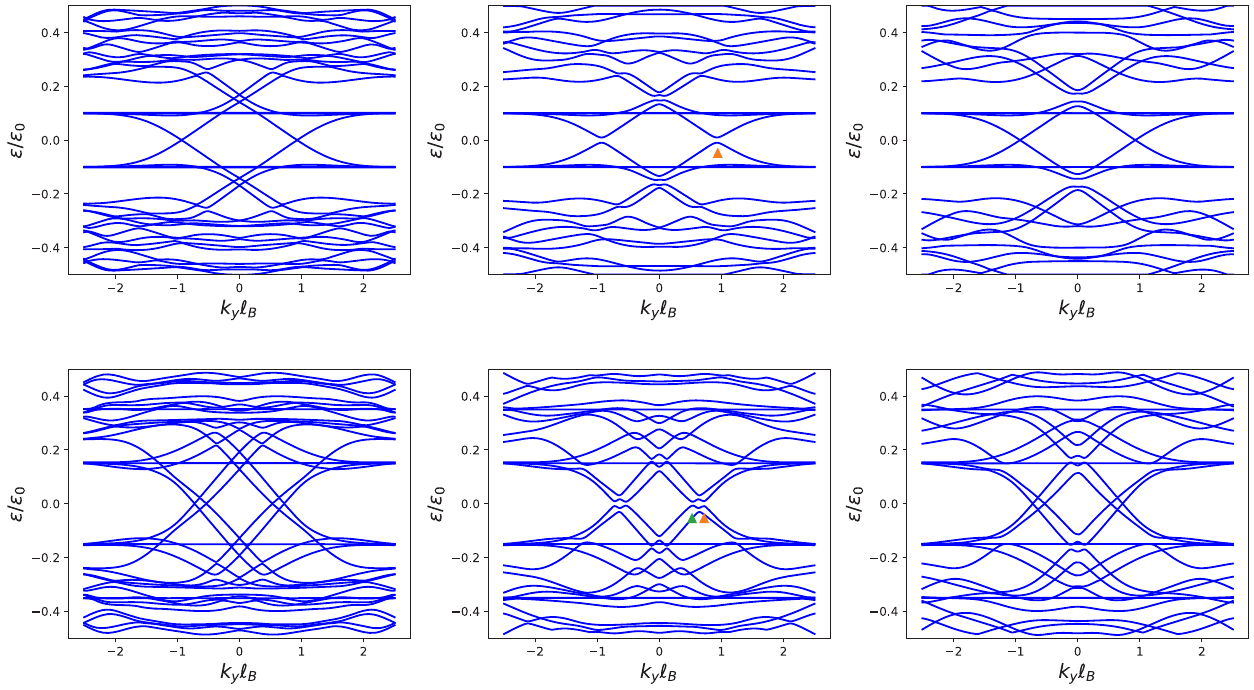
¼ 0 . 3 ε ν ¼ 2 with μ ¼ 0 . 55 ε FIG. 17. Bogoliubov spectrum. Top row: ν ¼ 1 with μ 0 . Bottom row: 0 (see the right-hand panel of n n Fig. S4 in Supplemental Material for the location of the chemical potential [35]). Left-hand column represents the case of a thick ¼ 15 l ¼ 10 ξ ¼ 6 l ¼ 4 ξ superconductor W 0 . Middle and right-hand column correspond to a thin superconductor W s 0 . There is no s B B energy gap in the thick regime, while there is a gap opening in the thin regime when spin-orbit coupling is present (middle column). For ¼ ε reference, we provide the right-hand column which has no spin-orbit coupling. In the other panels we set λ 0 . It is evident that Rx either turning off the spin-orbit coupling or making the superconductor thick prevents the edge modes from hybridizing and leads to a gapless spectrum with propagating Andreev edge states along the QH-superconductor interface. For these simulations, the system ¼ 3 ε μ ¼ 8 ε λ ¼ λ ¼ 0 , λ ¼ ε parameters are set as follows: Δ 1 ¼ 0 . 5 ε 0 , Δ 2 ¼ 0 . 6 ε 0 , m 0 , 0 , 0 s s Ry Rx SO